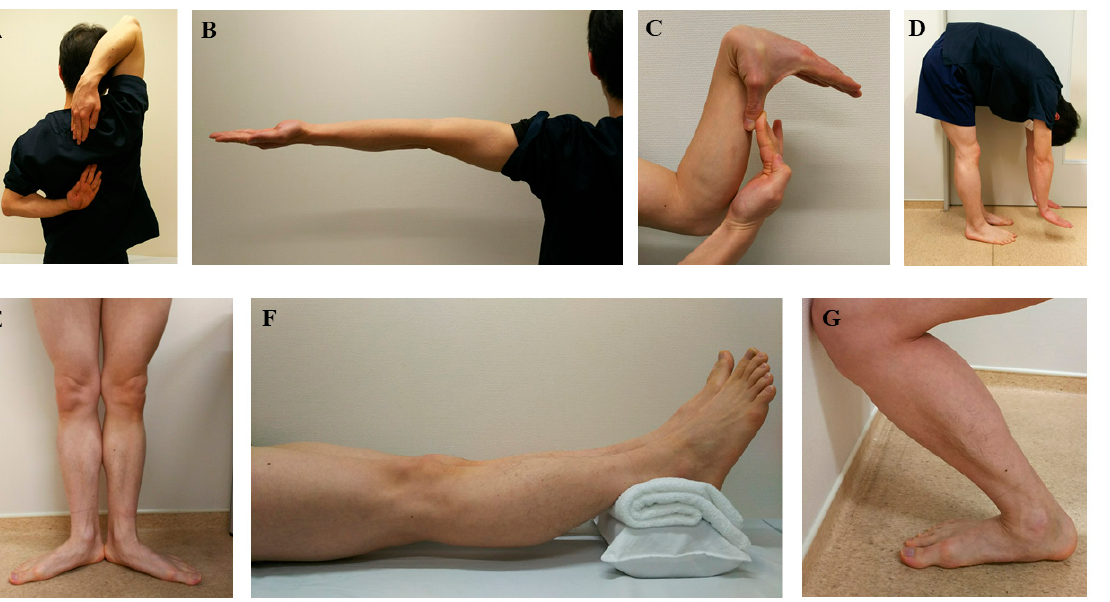
Figure 1. The Tokyo University score for generalized joint laxity. ( A ) . Crossing fingers behind the back. ( B ) . Hyperextension of both elbows beyond 15°. ( C ) . Passive opposition of both thumbs to volar aspects of ipsilateral forearms. ( D ) . Forward flexion of the trunk with the knees fully extended and palms resting on the floor. ( E ) . External rotation of both hips beyond 90°. ( F ) . Hyperextension of both knees beyond 10°. ( G ) . Weight-bearing ankle dorsiflexion range of motion beyond 45°. Tests other than D are bilateral. The patient receives a score for each individual joint, which is determined based on the evaluation of these items (score, 0 to 7).